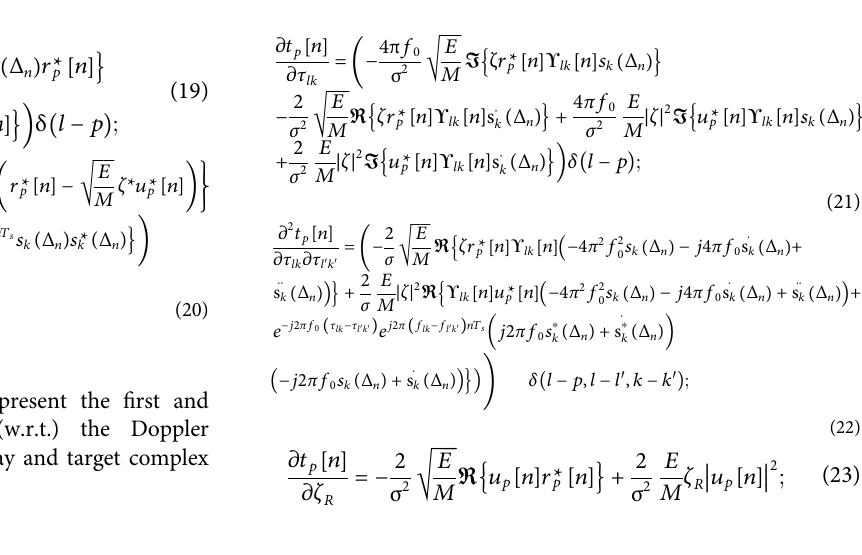
Frontiers in Signal Processing |